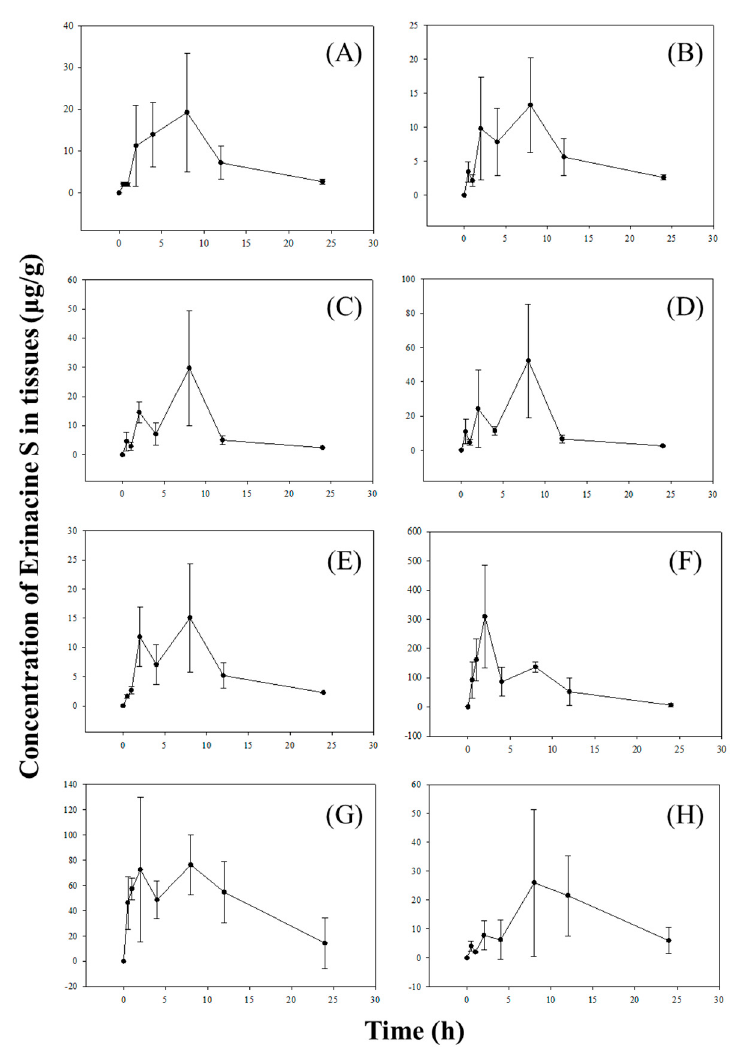
Figure 4. Mean plasma concentration–time curves of Erinacine S in ( A ) brain, ( B ) heart, ( C ) lung, ( D ) liver, ( E ) kidney, ( F ) stomach, ( G ) small intestine, and ( H ) large intestine of rats, after oral administration of the H. erinaceus mycelia extract at 2.395 g / kg body weight (equivalent to 50 mg / kg body weight of Erinacine S). Values are means ± SD ( n = 6).